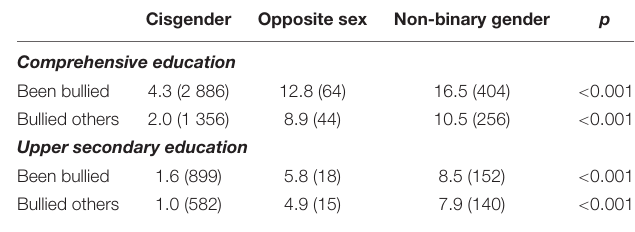
TABLE 2 | Experiences of bullying and bullying others according to gender identity,%